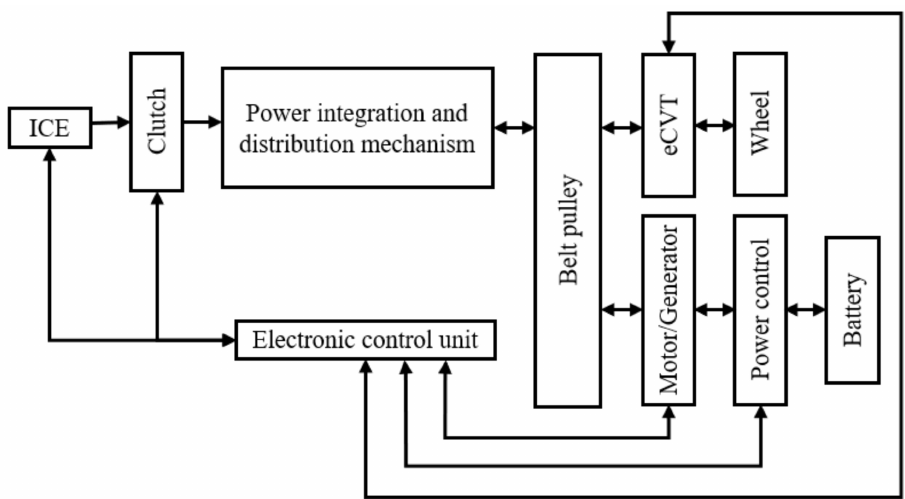
Figure 1. The architecture diagram of the HEV